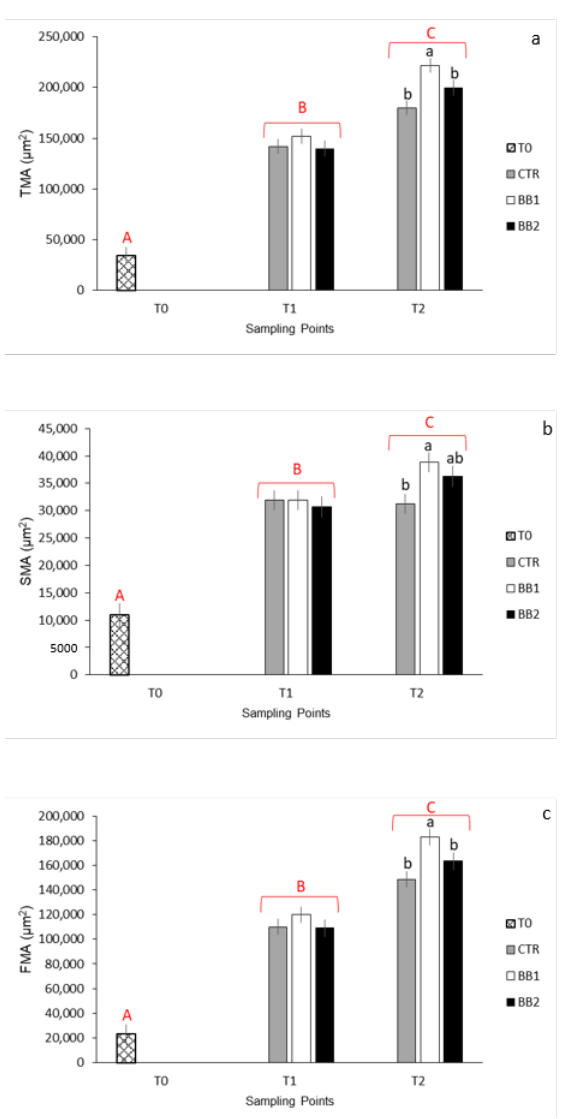
Figure 4. Quantitative representation of: ( a ) total muscle cross-sectional area (TMA): area expressed in µ m 2 ; n = 18/group; ( b ) red muscle area (slow muscle cross-sectional area, SMA), area expressed in µ m 2 ; n = 18/group; ( c ) white muscle area (fast muscle cross-sectional area, FMA), area expressed in µ m 2 ; n = 18/group; a,b Means with different superscripts differ significantly between treatments (black font) or stages of development (red font) ( p < 0.05); A,B,C Means with different superscripts differ significantly between treatments (black font) or stages of development (red font) ( p < 0.01).